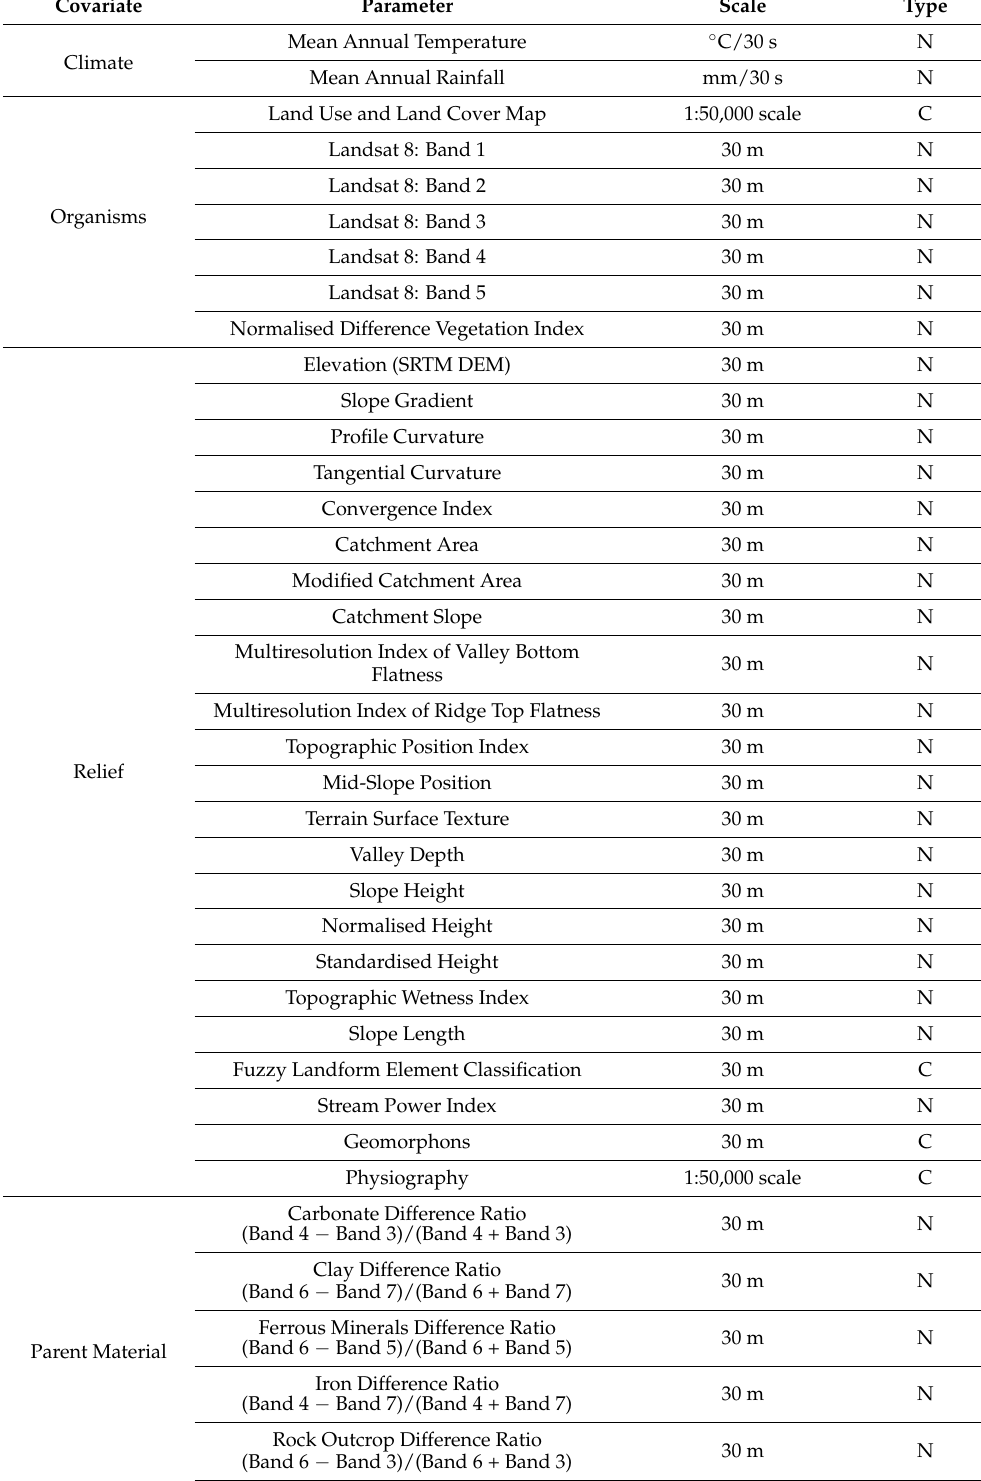
Table 1. List of environmental covariates. Covariate Parameter